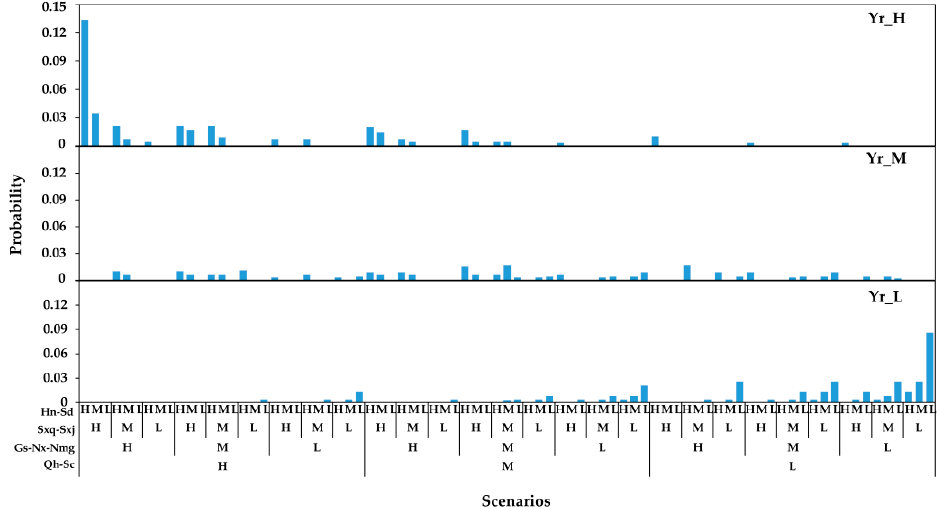
Figure 5. Scenarios and probabilities of wet–dry encounters in the Yellow River Basin and its re- gions.